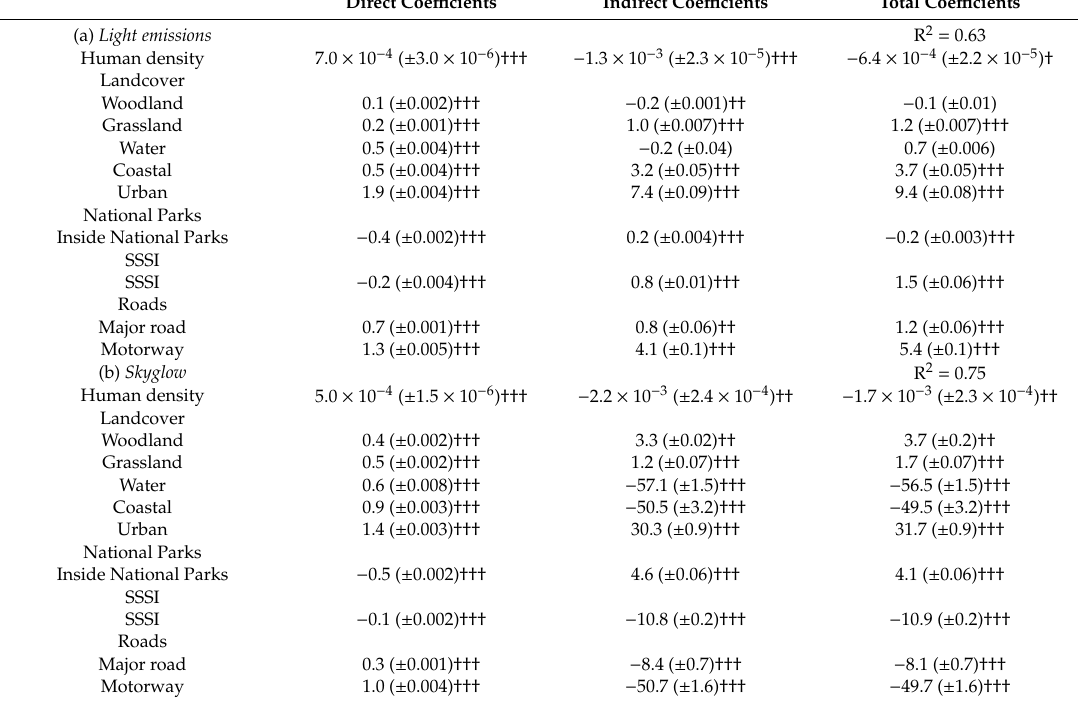
Table 2. Associations between ( a ) light emissions or ( b ) skyglow and five potential correlated variables on mainland Britain. We show the direct (e ff ect of independent variables on the response), indirect (mean e ff ect of independent variables of the nearest neighbor areas on the response) and total (direct and indirect combined) unstandardized coe ffi cients. Spatial weights distance for light emissions was 30 km and for skyglow was 130 km. Factor variables are against a base factor level, i.e., for landcover the base factor level is mountain, heath, bog, thus, a positive coe ffi cient suggests that other habitats receive more artificial light at night; the base factor levels for other variables are: National Parks, pixel is outside of a National Park; SSSI, pixel is outside of a SSSI; roads, no road or minor roads. We simulated the model 200 times for each response variable, and we present the mean coe ffi cient and standard error of the mean. Statistical significance is shown ( ††† > 90% of models had a P value < 0.05; †† > 75–90% of models; † 60–75% of models; variables which had a p-value of > 0.05 in < 60% of models were considered to have marginal e ff ects). We show the mean pseudo r squared across all